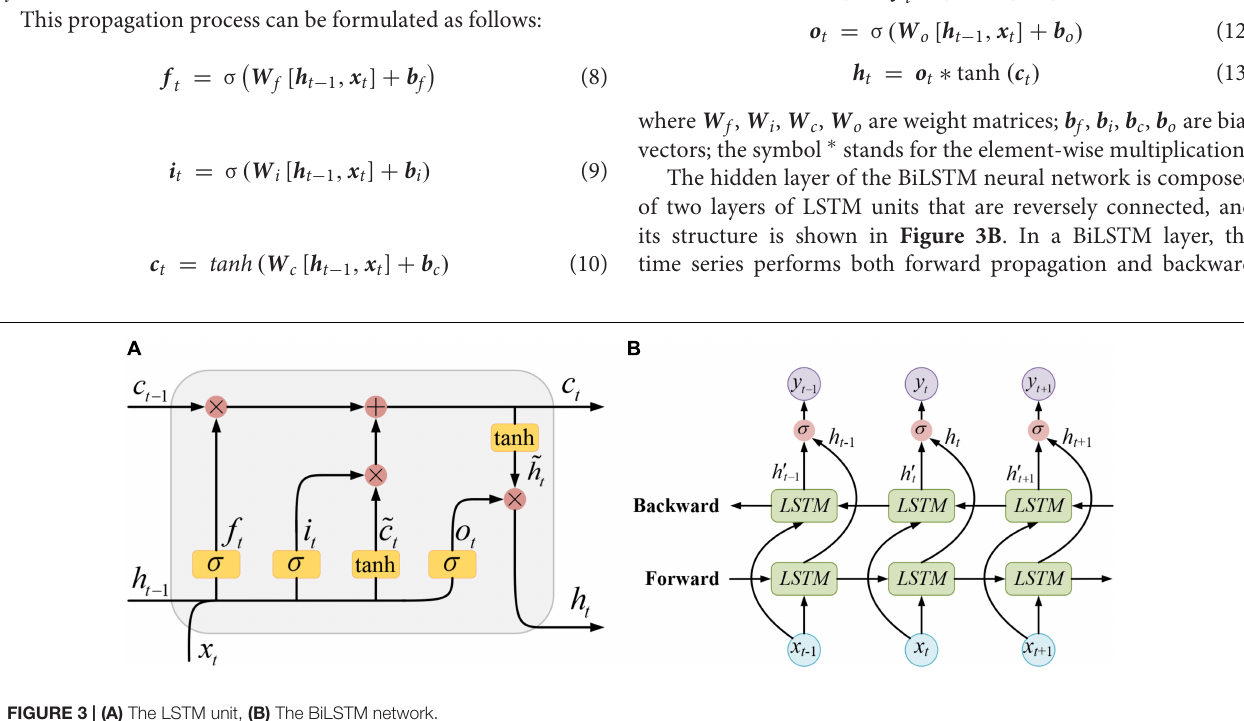
FIGURE 3 | (A) The LSTM unit, (B) The BiLSTM network.